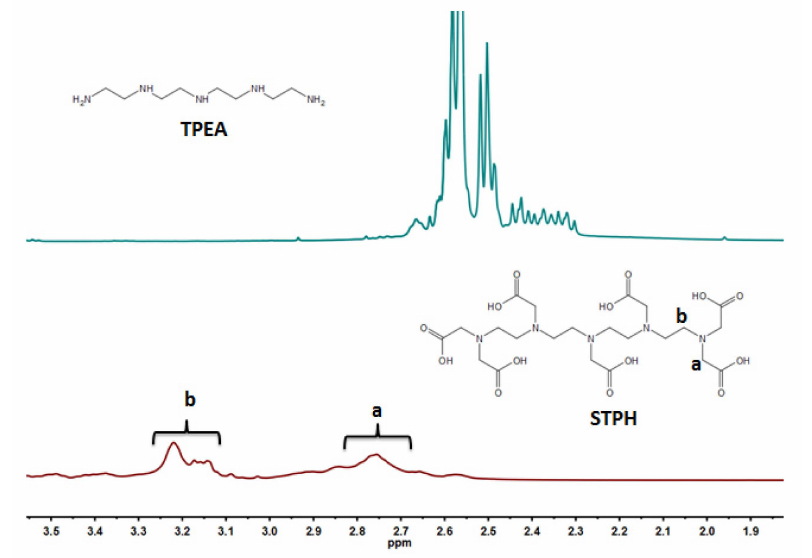
Figure 1. Nuclear magnetic resonance spectroscopy ( 1 H-NMR) characterization of the compound STPH.